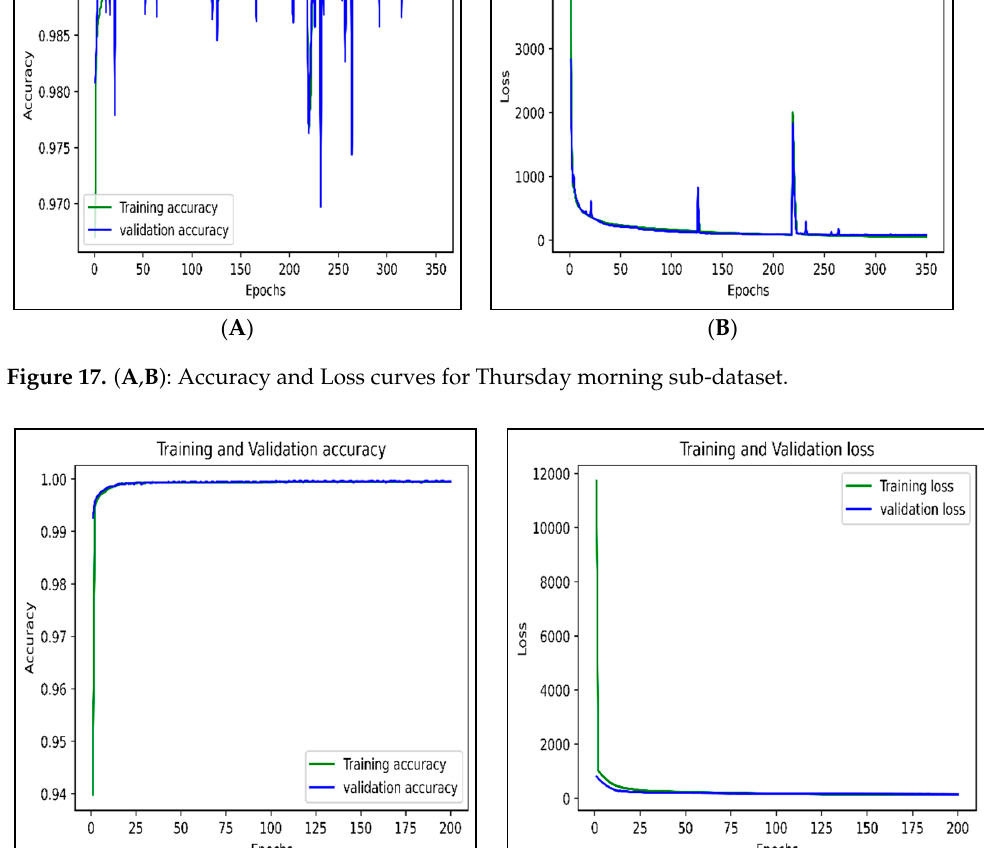
Figure 18. ( A,B ): Accuracy and Loss curves for Thursday afternoon sub-dataset.